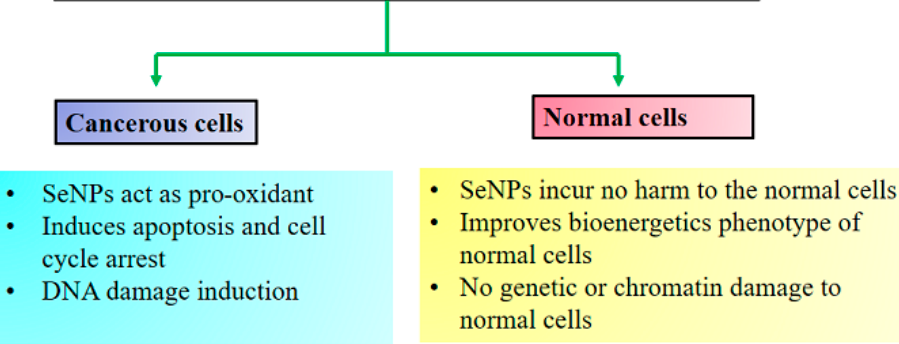
Figure 2. Differential anticancer effect of SeNPs. Adopted from Khurana et al. [106].